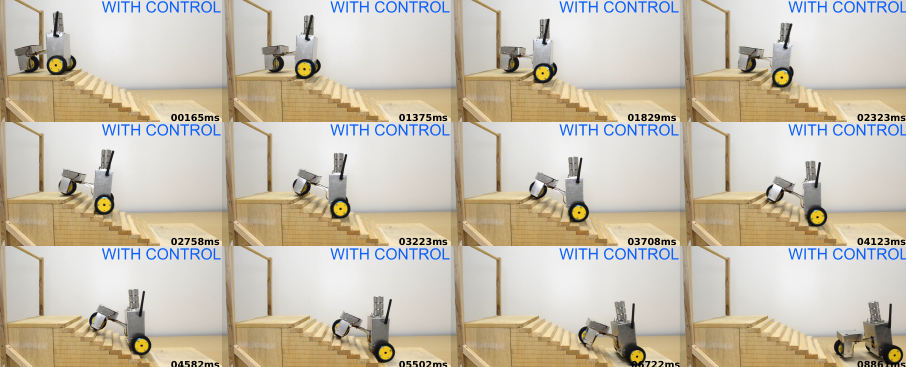
Figure 19. Prototype descending with control (time stamps in milliseconds are roughly estimated from the